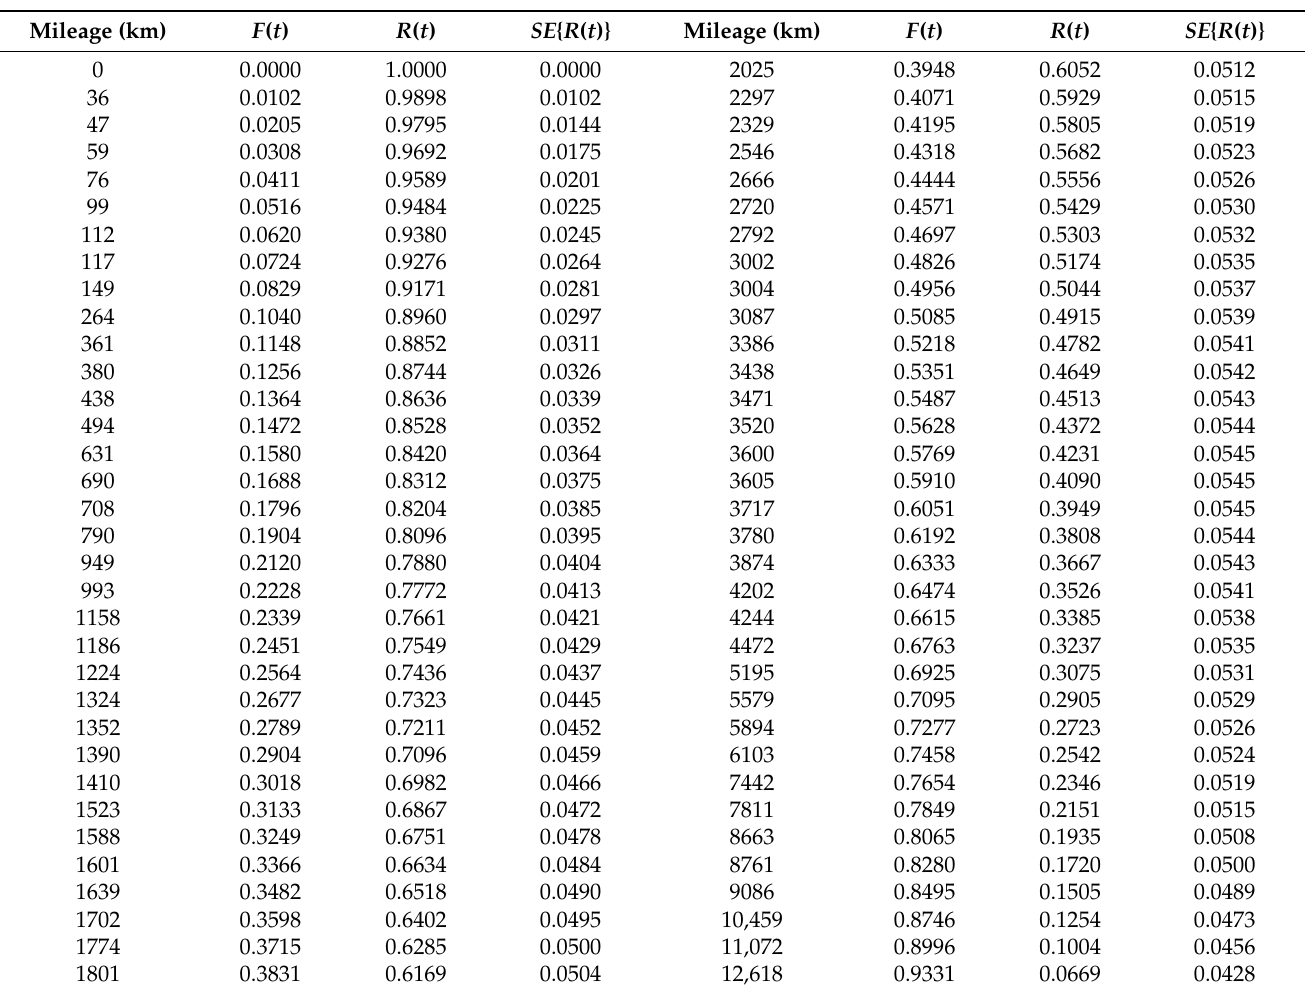
Table 3. Estimated values of unreliability and reliability